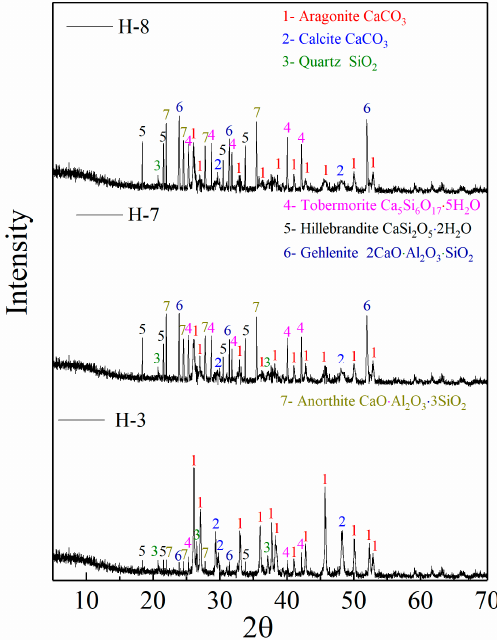
Figure 3. XRD patterns of sample H-3, sample H-7 and sample H-10.